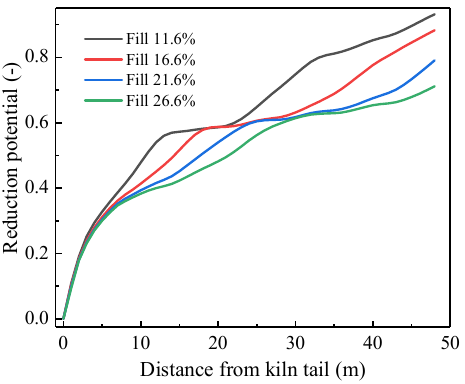
Figure 15. Reduction potential along the axial section for different fill degree.